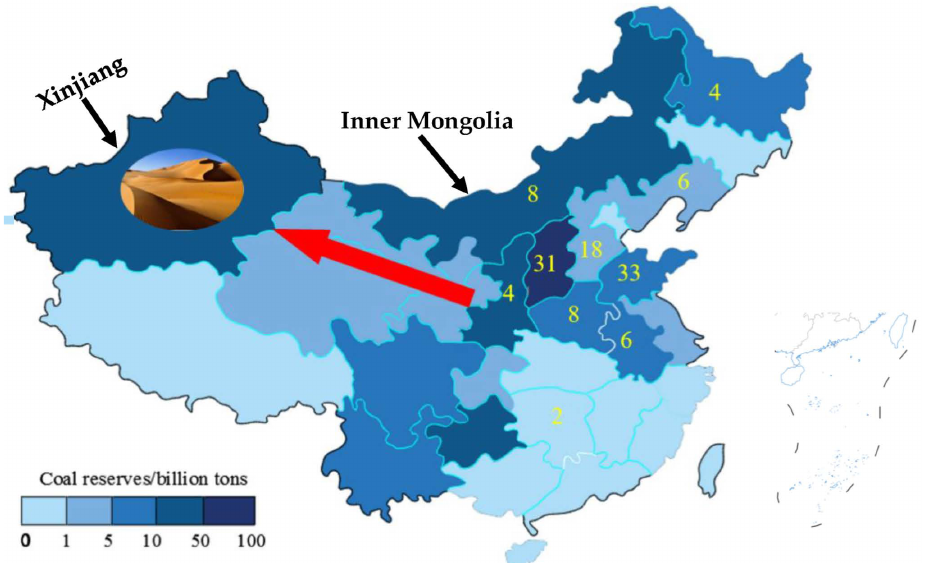
Figure 31. Distribution of coal resources and backfill mining projects in China. The numbers represent the amount of coal reserves in